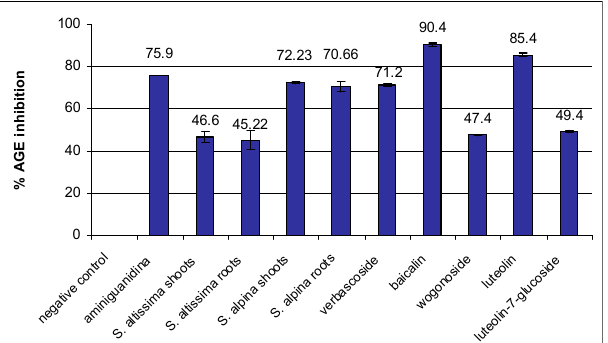
Figure 2. Antiglycation activity (expressed as % inhibition of AGE formation) of S. altissima (shoot, root) extracts, S. alpina (shoot, root) extracts and the main compounds present in the analyzed extracts (verbascoside, baicalin, wogonoside, luteolin, luteolin-7-glucoside). BSA after glycation (100% AGE) was used as the negative and aminoguanidine as the positive control. All extracts and compounds were used at a concentration of 100 μ g/mL. The results are the mean values ± SE A high correlation was observed between extract antiglycation activity and total flavonoid content (mg quercetin equivalents /g extract dry wt) (r = 0.99) (Table 2). Lower, but also significant, was